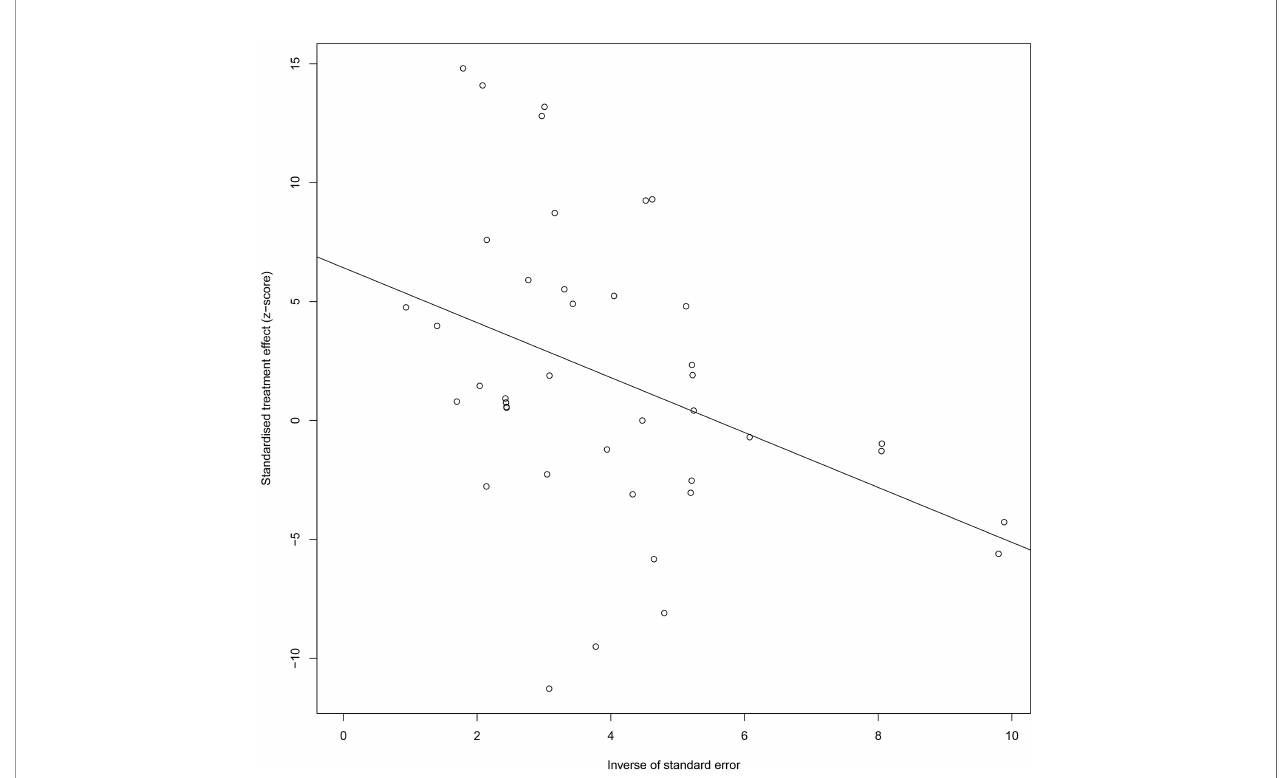
FIGURE 3 | Egger funnel plots of GDM patients compared to controls. GDM patients chemokine and chemokines receptor compared to patients with controls, t = 2.03, p-value = 0.061. Egger funnel plots to assess publication bias. Plots show study size as a function of effect size for studies included in the meta-analysis. The dots represent each study. GDM, Gestational diabetes mellitus.